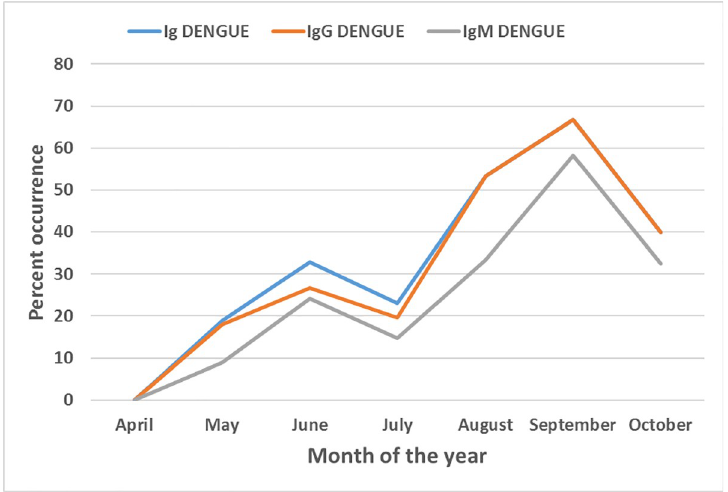
Fig 1. Seasonal distribution of dengue virus infection among children with fever attending hospitals in Yaounde. Ig represents all cases of dengue infections (past and current infections). IgG represents cases of previous exposure to dengue. IgM represents current cases of